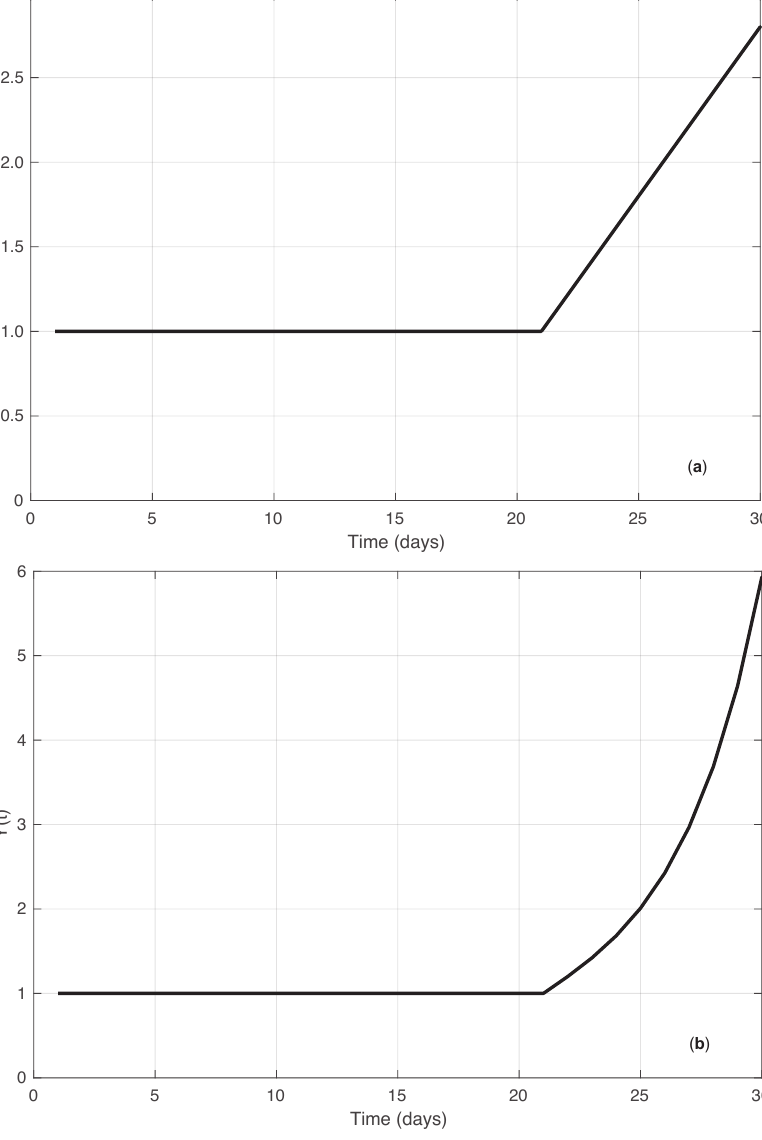
Figure 14. Synthetic epidemic data of the second type (see Section 3.2). In panel ( a ), we show the R t sequence along time. The value of the slope α of the linear growing phase is 0.2 (days − 1 ). In panel ( b ), we show the corresponding incidence data recursively obtained from Equation